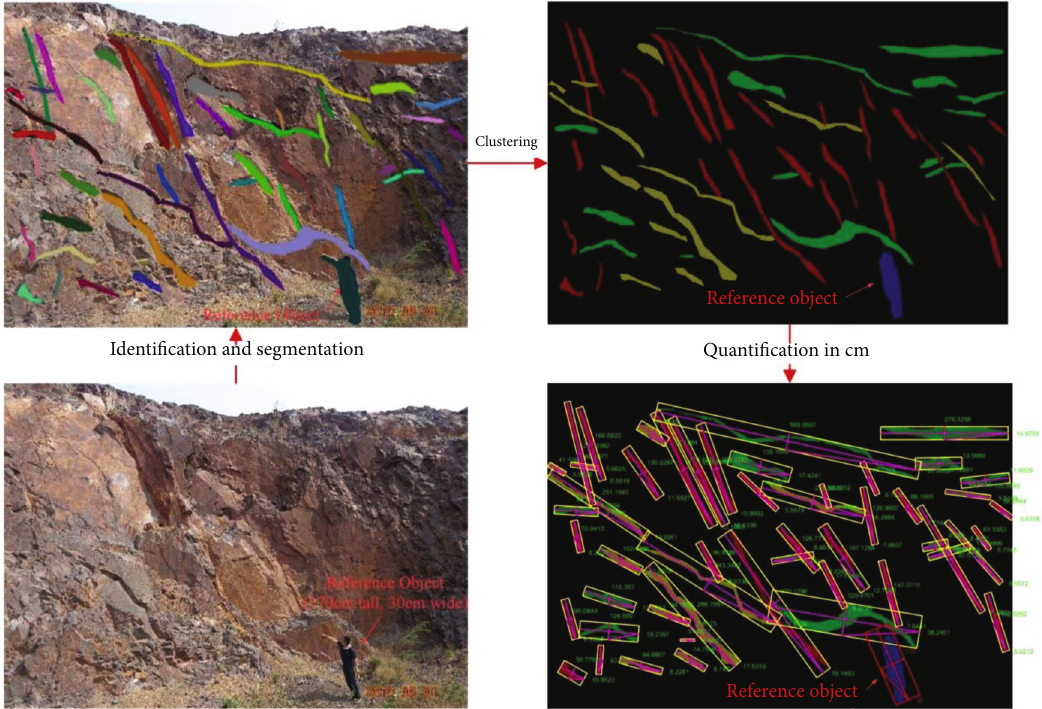
Figure 22: Quanti fi cation in cm of discontinuity trace on the selected outcrop with a reference object.